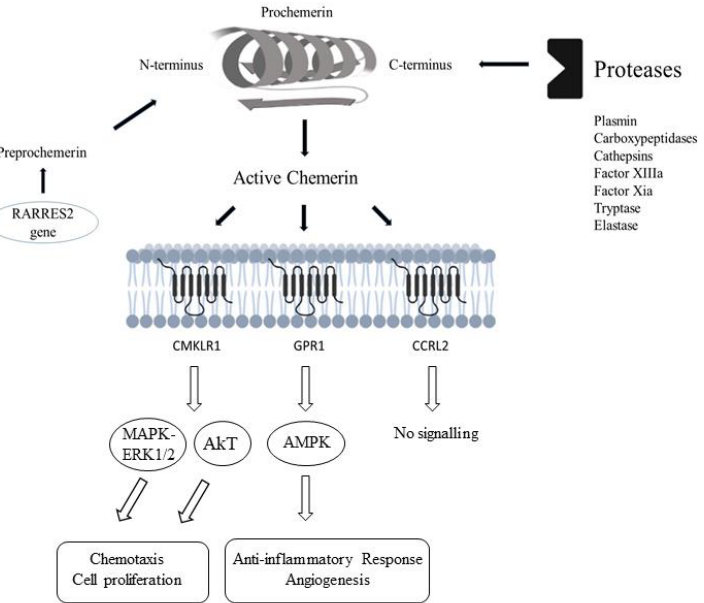
Figure 1. Chemerin synthesis and receptor signalling. RARRES2 retinoic acid receptor responder 2; CMKLR1 chemokine-like receptor 1; GPR1 G protein-coupled receptor 1; CCRL2 C-C chemokine receptor-like 2. Generated with Biorender.com.